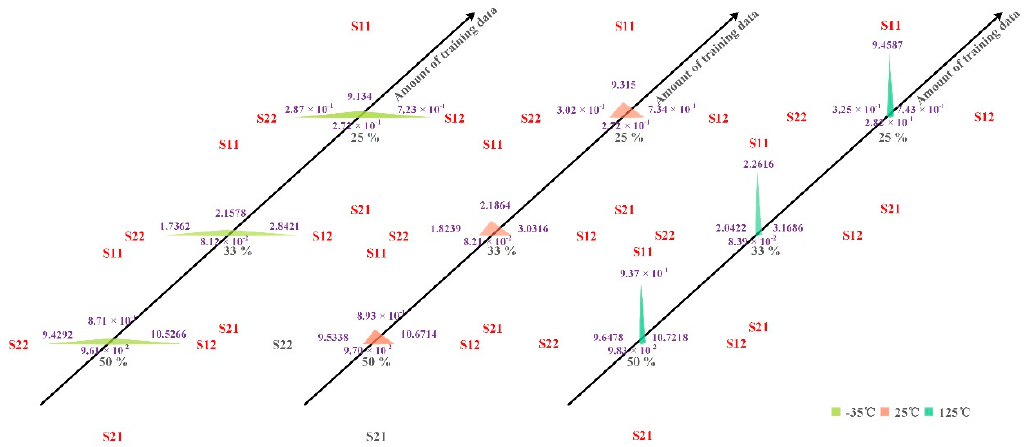
Figure 9. Test error of different amounts of training data on the model.